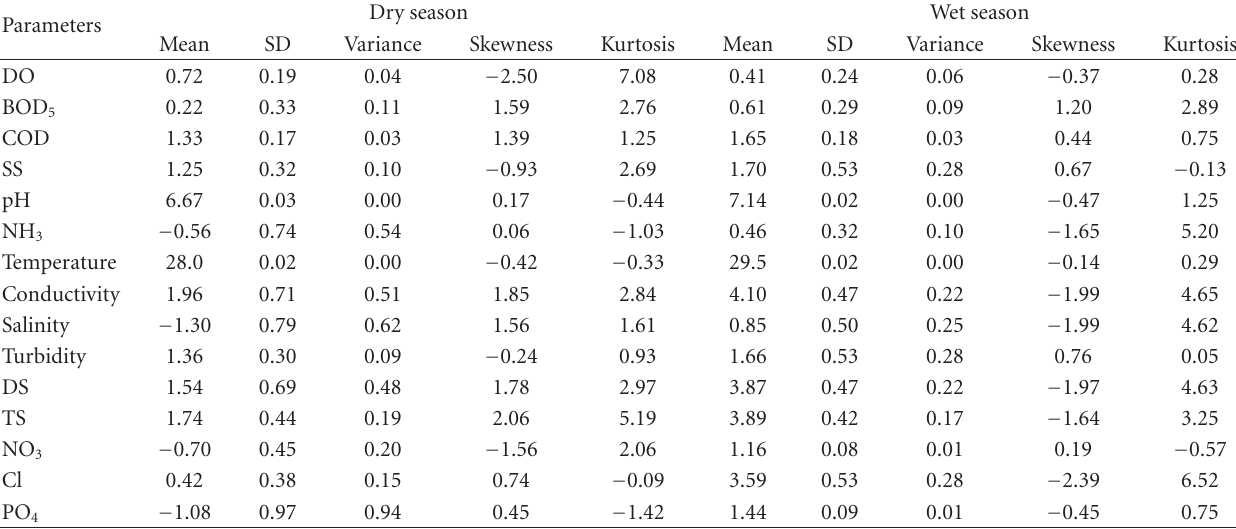
Table 1: Descriptive statistics of physicochemical parameters under study in mg/L except temperature, conductivity, and pH.